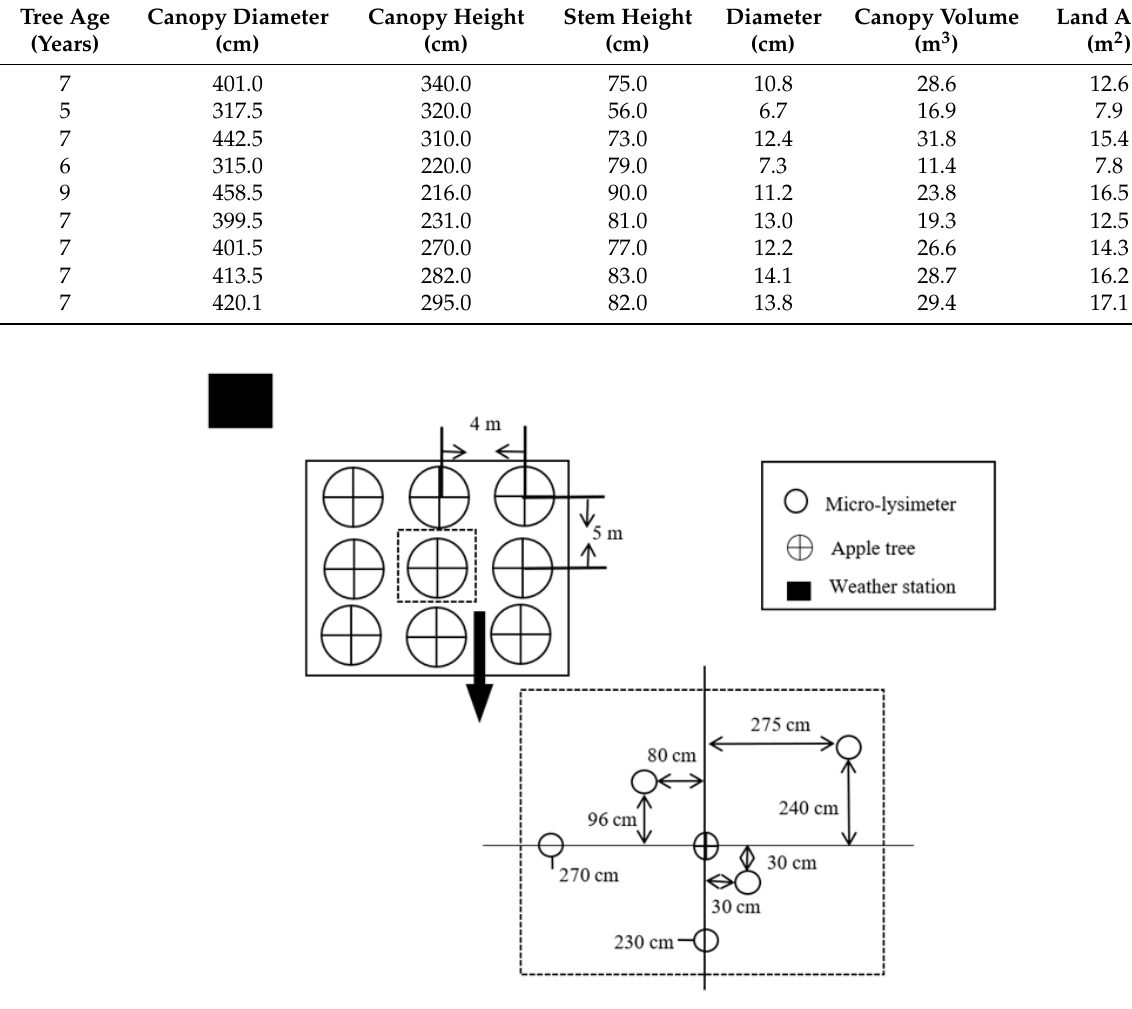
Figure 1. Location of micro-lysimeters.